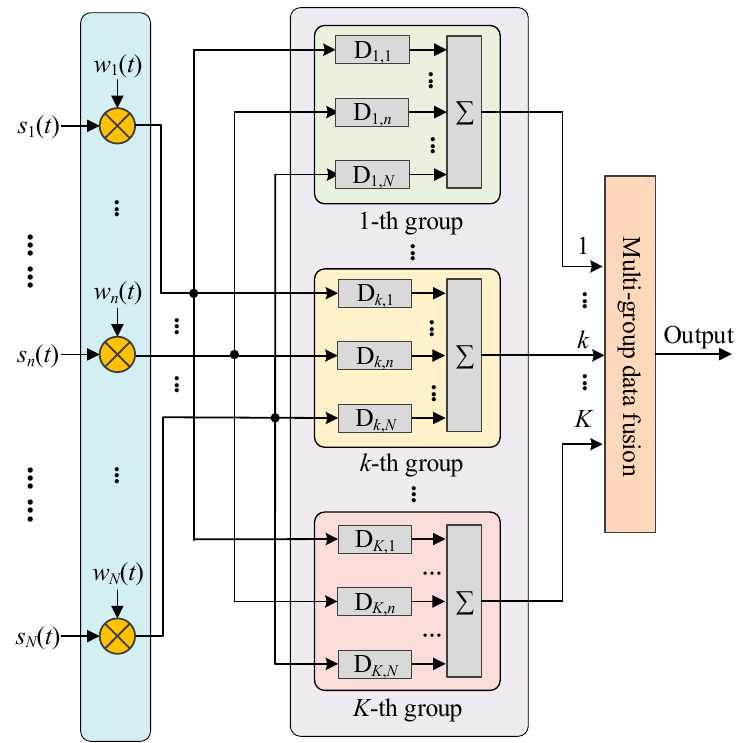
Figure 4. Processing diagram of the improved DBF processor with multi-group time delays.